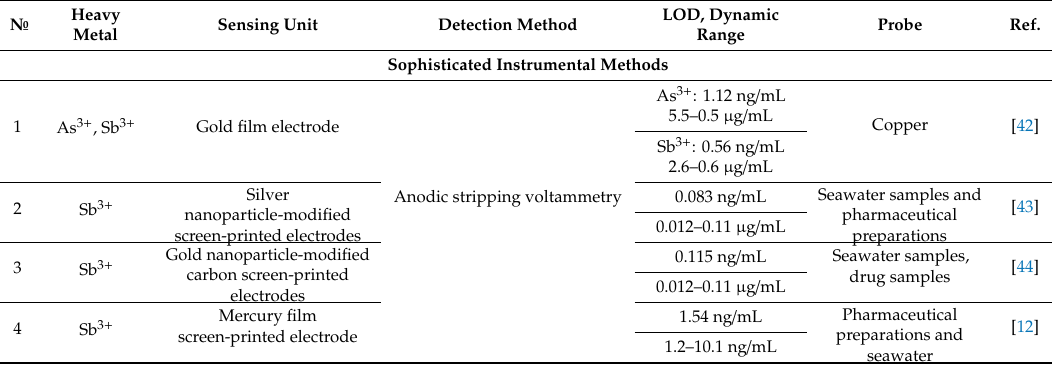
Table 1. Described assays for the determination of antimony.